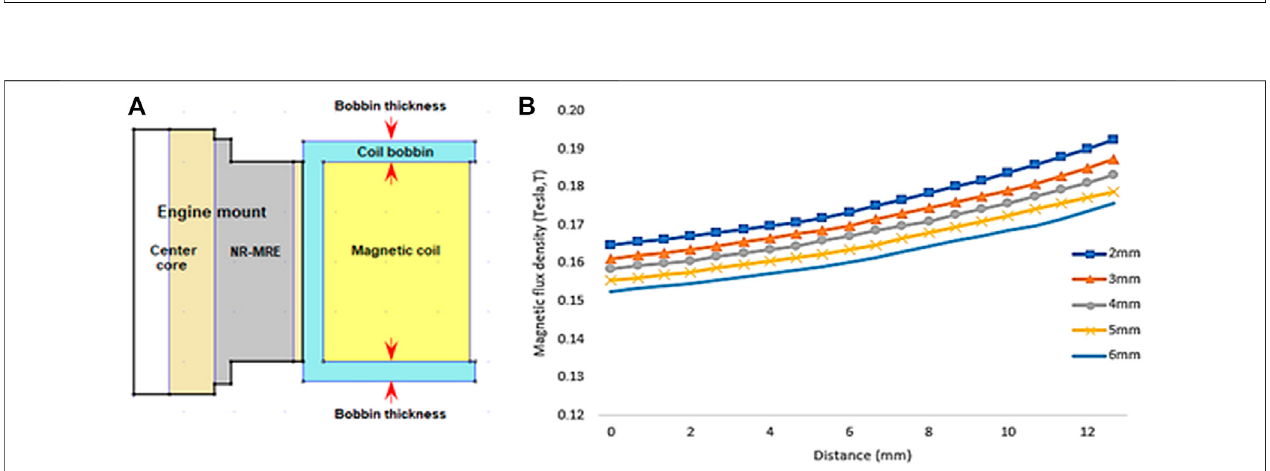
Frontiers in Materials |